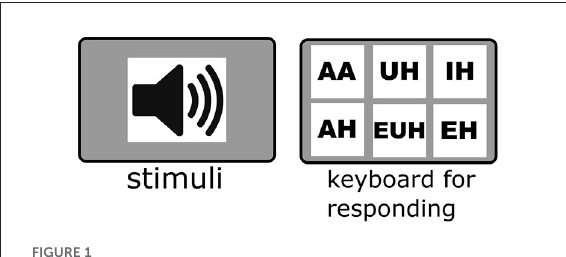
FIGURE1 Experimental paradigm. Participants listen to randomized audio clips containing either CVC or vowel-only sounds then respond via a keyboard press to indicate which vowel sound they